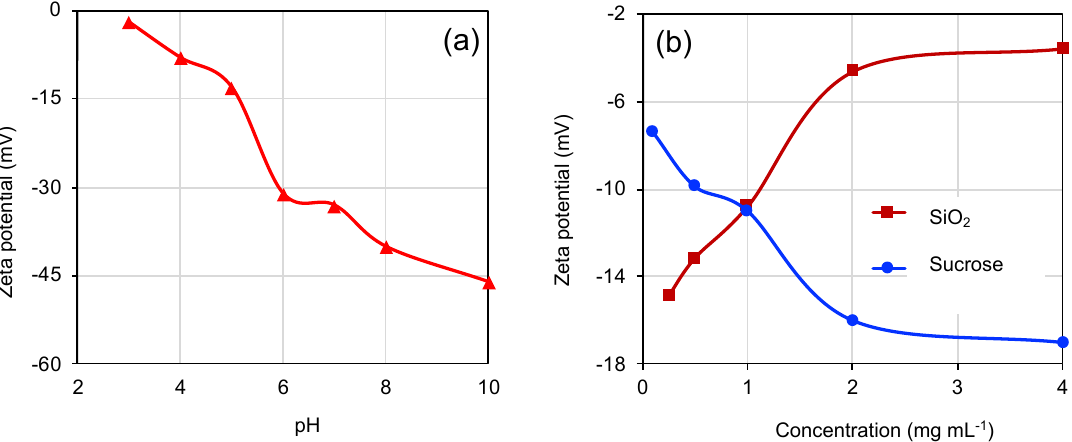
Figure 2. Graphs showing the zeta potential analysis of SiO 2 with respect to pH ( a ) and concentration at pH 6 ( b ) to optimize the hydrothermal carbonization process.